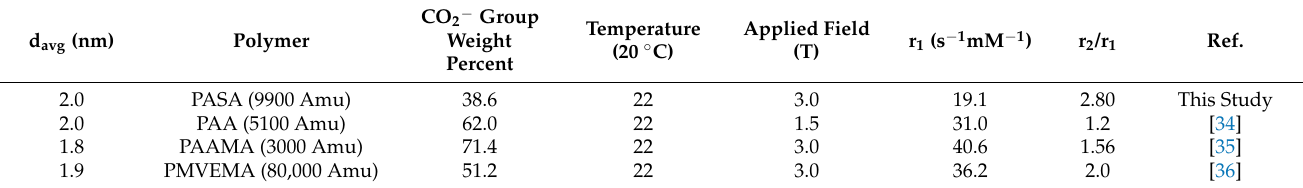
Table 3. r 1 and r 2 values of various polymer-coated Gd 2 O 3 nanoparticles.